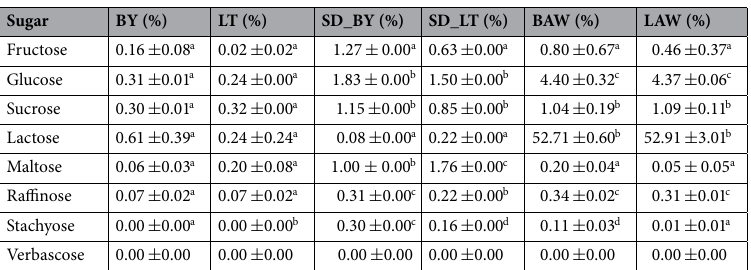
Table 3. Sugar profile of millet flours and acid whey millet powders. Means having different letters as superscripts within the same row differ significantly at p < 0.05. Sugar profile of powder samples. BY: plain Barnyard millet flour; LT: plain Little millet flour; SD_BY: spray dried Barnyard millet soluble fraction; SD_LT: spray dried Little millet soluble fraction; BAW: 25% w/v Barnyard millet + acid whey; LAW: 25% w/v Little millet + acid